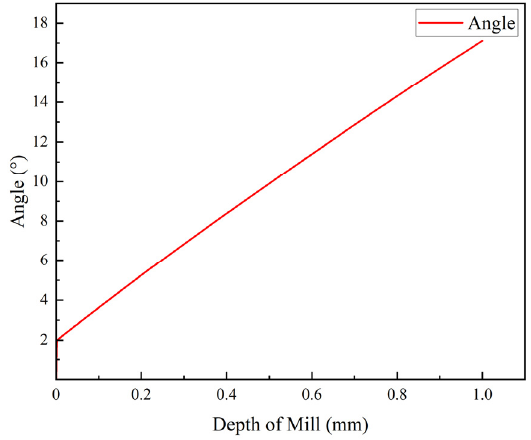
Figure 8. Relationship between angle and milling depth.